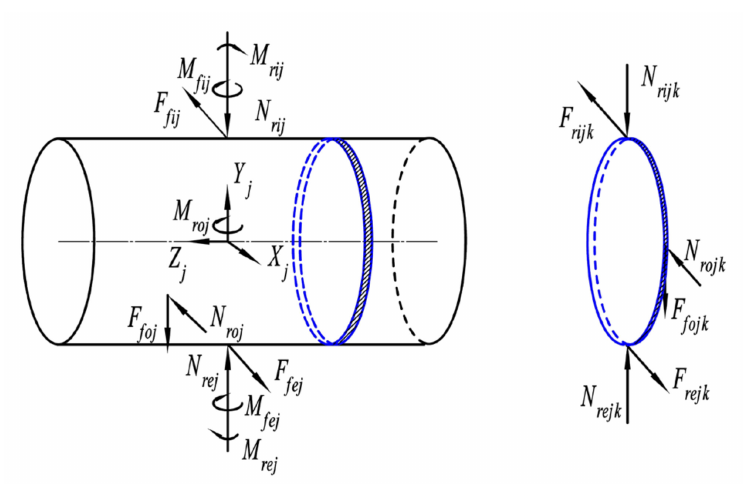
Figure 9. Force model of needle